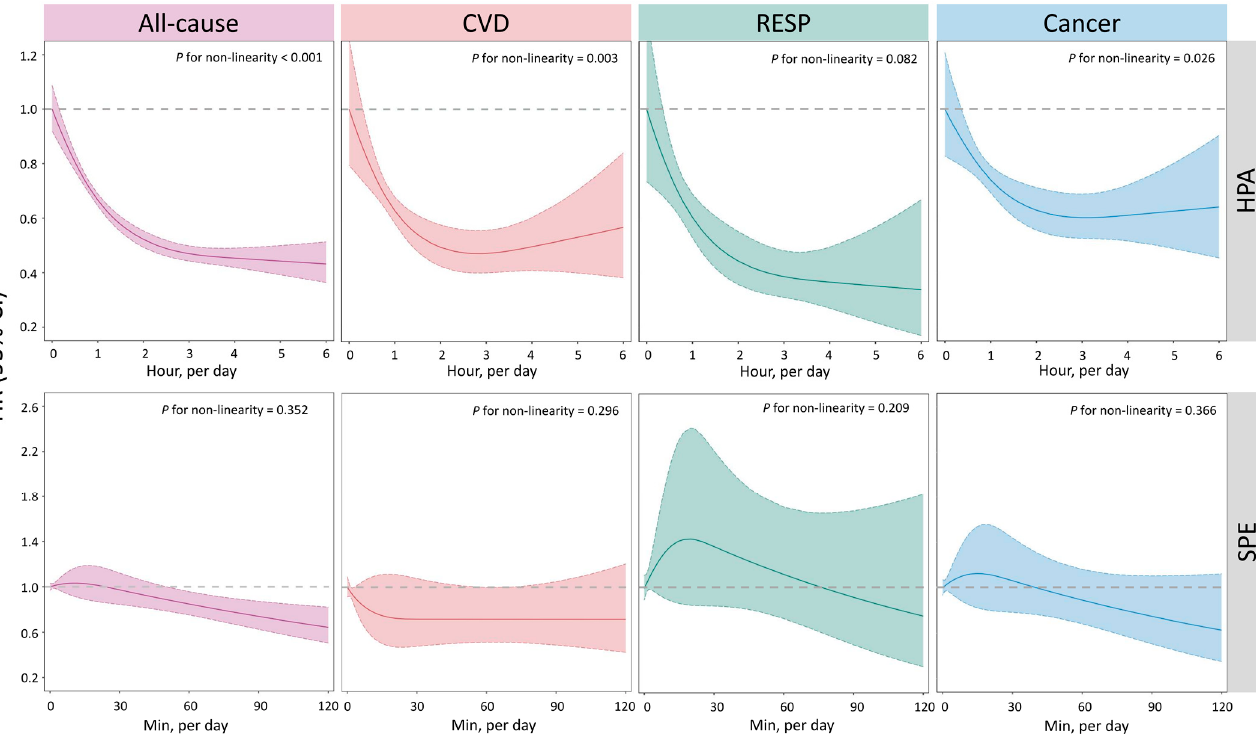
Figure 2. Multivariable-adjusted spline curve for a relation between estimated HPA and SPE with all-cause, CVD, RESP, and cancer mortality. We adjusted for gender, age, BMI, ethnicity, marital status, residential region, geolocation, education attainment, employment status, household income, smoking status, alcohol consumption, sleep duration, and chronic disease. Abbreviations: HPA, household physical activity; SPE, sport and physical exercise; CVD, cardiovascular disease; RESP, respiratory disease; HR, hazard ratio; CI, confidence interval.